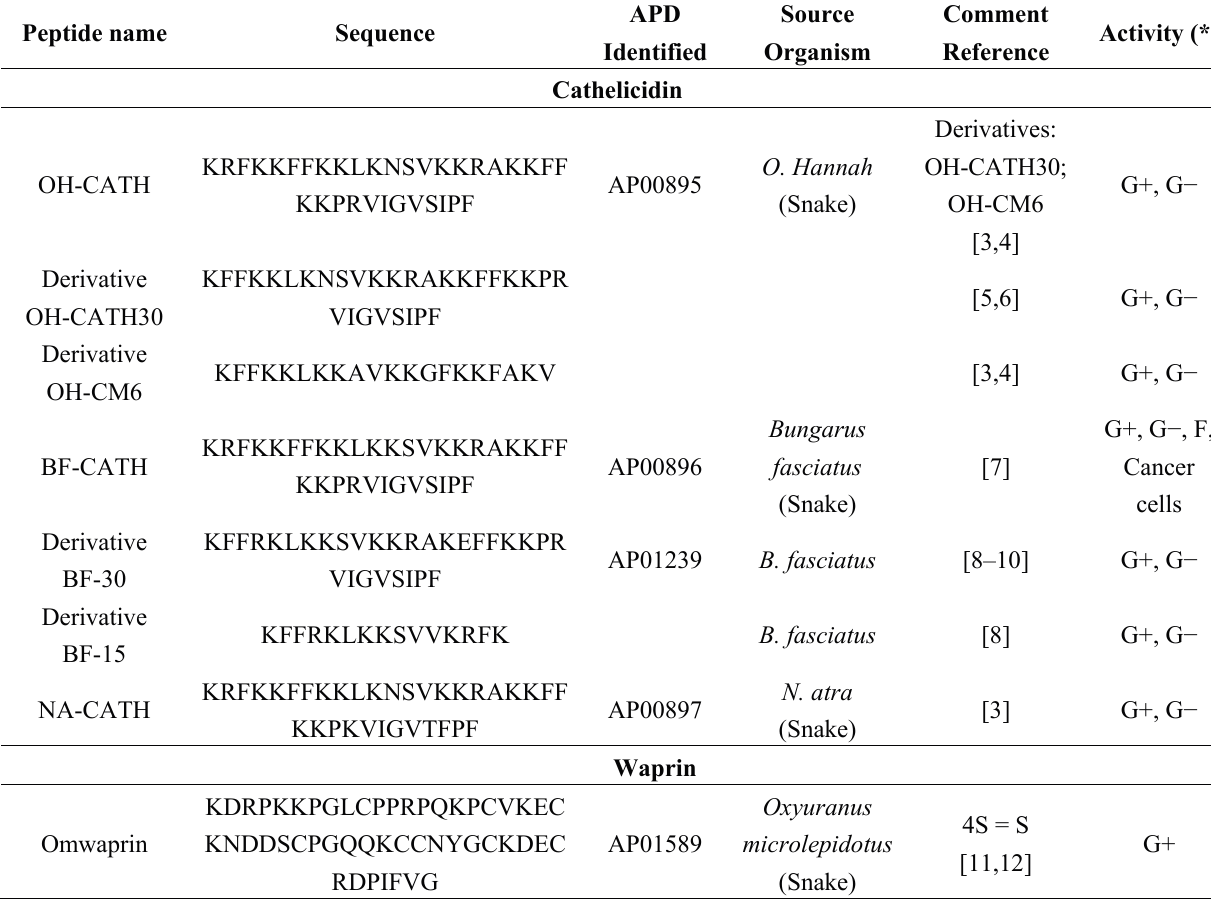
Table 1. Known reptile antimicrobial peptides identified in the Antimicrobial Peptide Database (APD2)